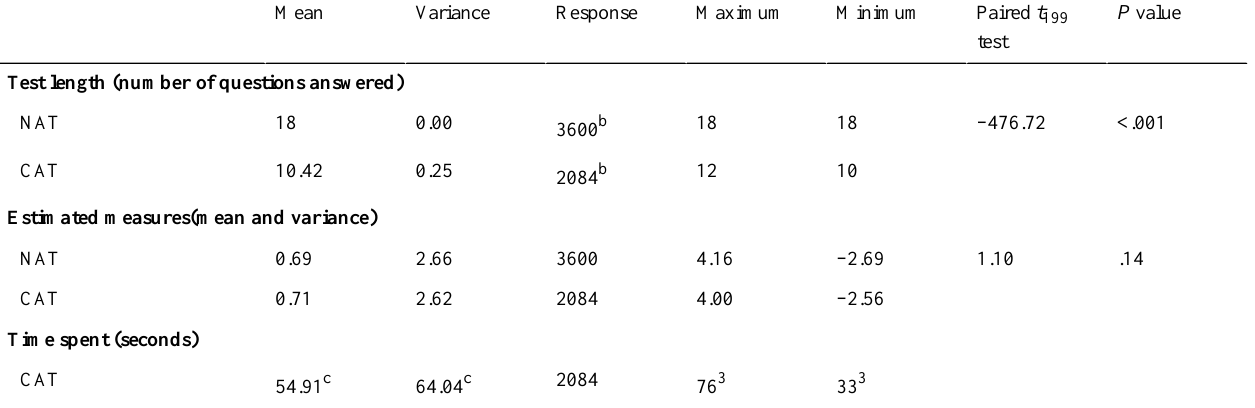
Table 3. Comparison of computerized adaptive testing (CAT) versus nonadaptive testing (NAT) (all questions having to be answered) in efficiencya as assessed by paired t test